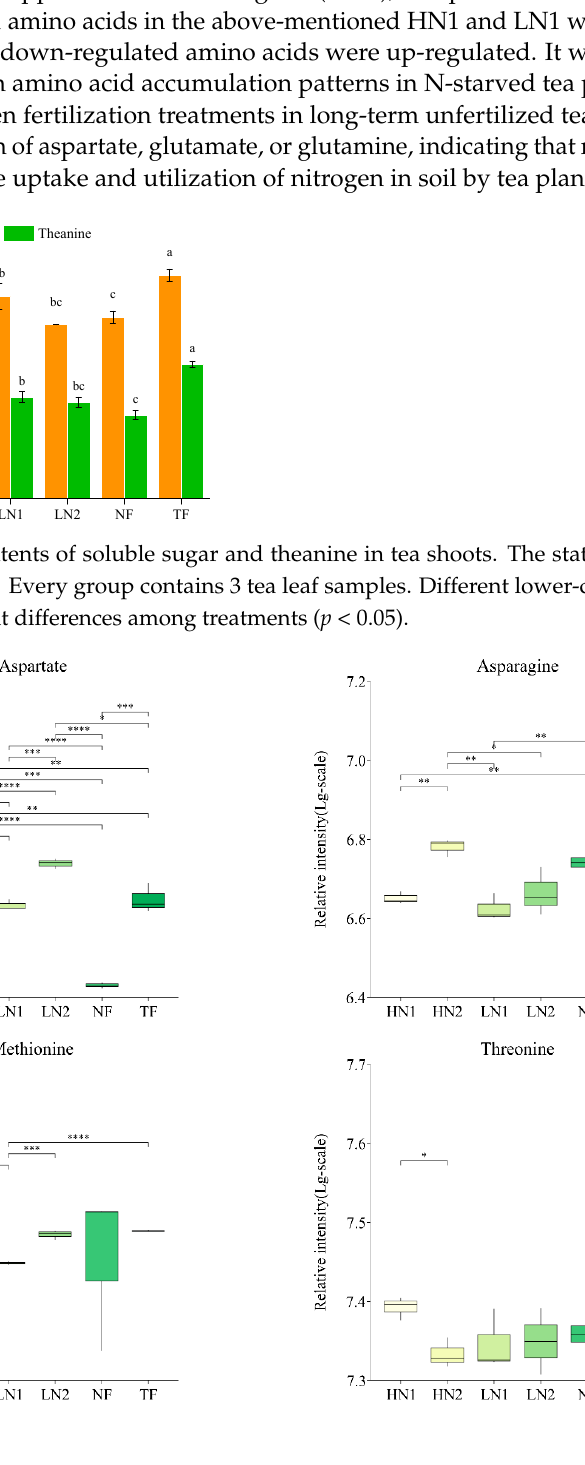
Figure 1. Yields with different N supplies. The statistical approach used was LSD (least significant difference) analysis. Every group contains 3 tea leaf samples. Different lower-case letters above the bars indicate significant differences among treatments ( p < 0.05 ).